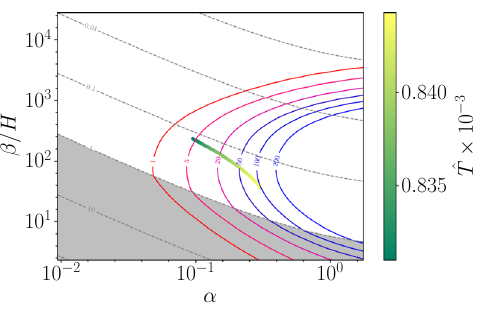
Fig. 2 Scatter plots displaying the SNR for the points detectable by LISA. The color bar denotes the value of ˆ T . Higher values of the range of ˆ T correspond to higher intensities of the GW signals Table 1 Benchmark FOPT solutions that can be detected in future GW space-based interferometers